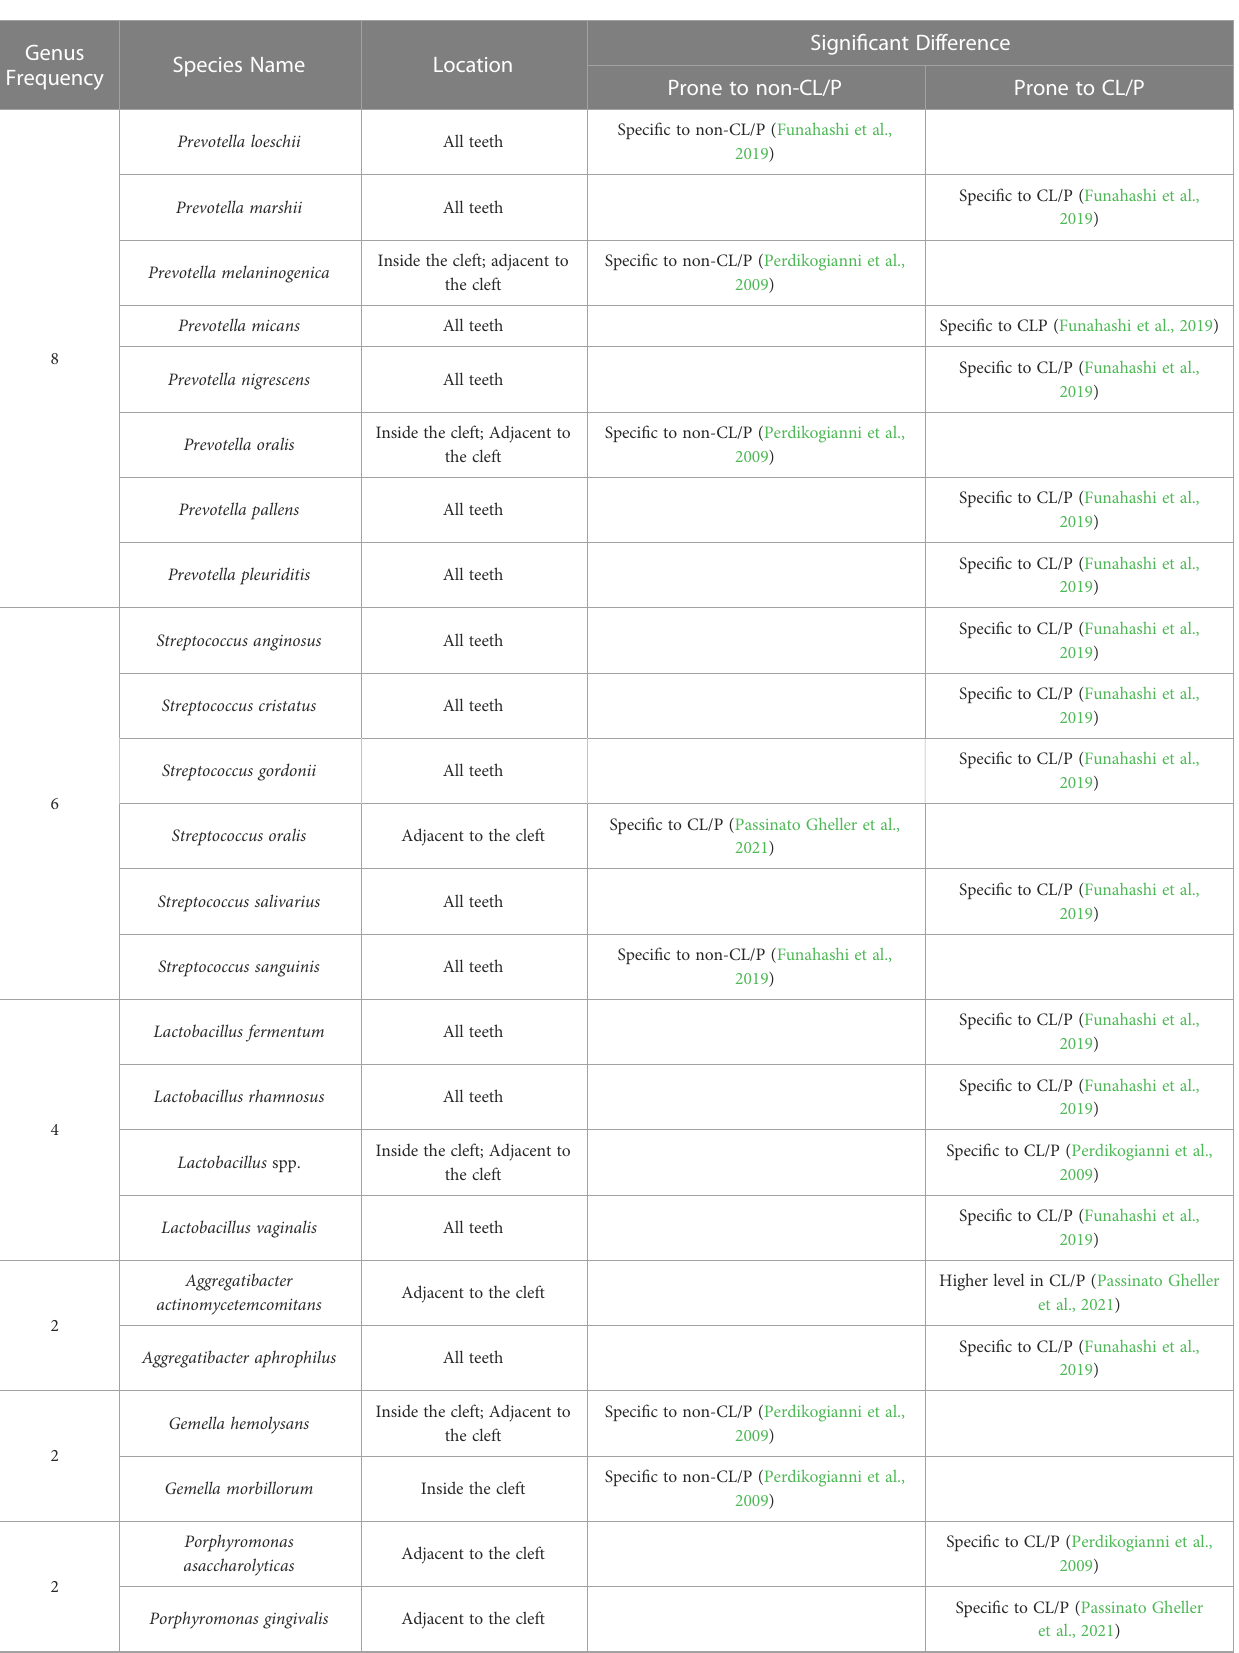
TABLE 1 Signi fi cant differences in bacterial species obtained from the teeth of CL/P and non-CL/P patients.